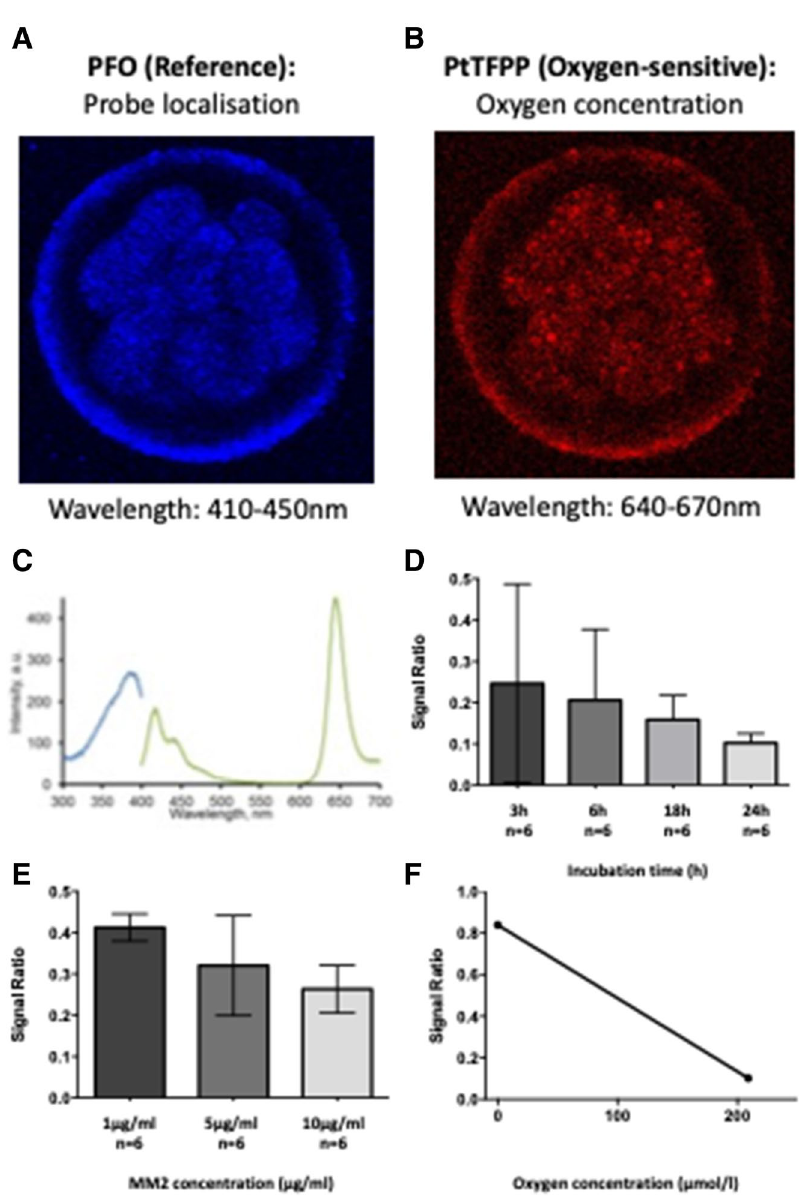
Figure 1. Optimisation and calibration of MM2 incubation conditions. Examples images ( A ) PFO oxygen- insensitive fluorophore labelling; ( B ) PtTFPP oxygen-sensitive labelling; ( C ) Excitation/Emission spectra reproduced from manufacturer guidance, ( D ) Signal ratio comparison following blastocyst incubation with MM2 probe for 3 (n = 6), 6 (n = 6), 18 (n = 6) and 24 h (n = 6), with no statistical differences; ( E ) Blastocysts imaged after 24 h incubation with 1 μg/ml (n = 6), 5 μg/ml (n = 6), or 10 μg/ml (n = 6) MM2 probe with no significant differences; ( F ) Example calibration based on blastocysts imaged at 0% and 21% O 2 (p < 0.0001) with curve y = − 0.0035x + 0.84. Values plotted as mean ± SD for the number of analyses